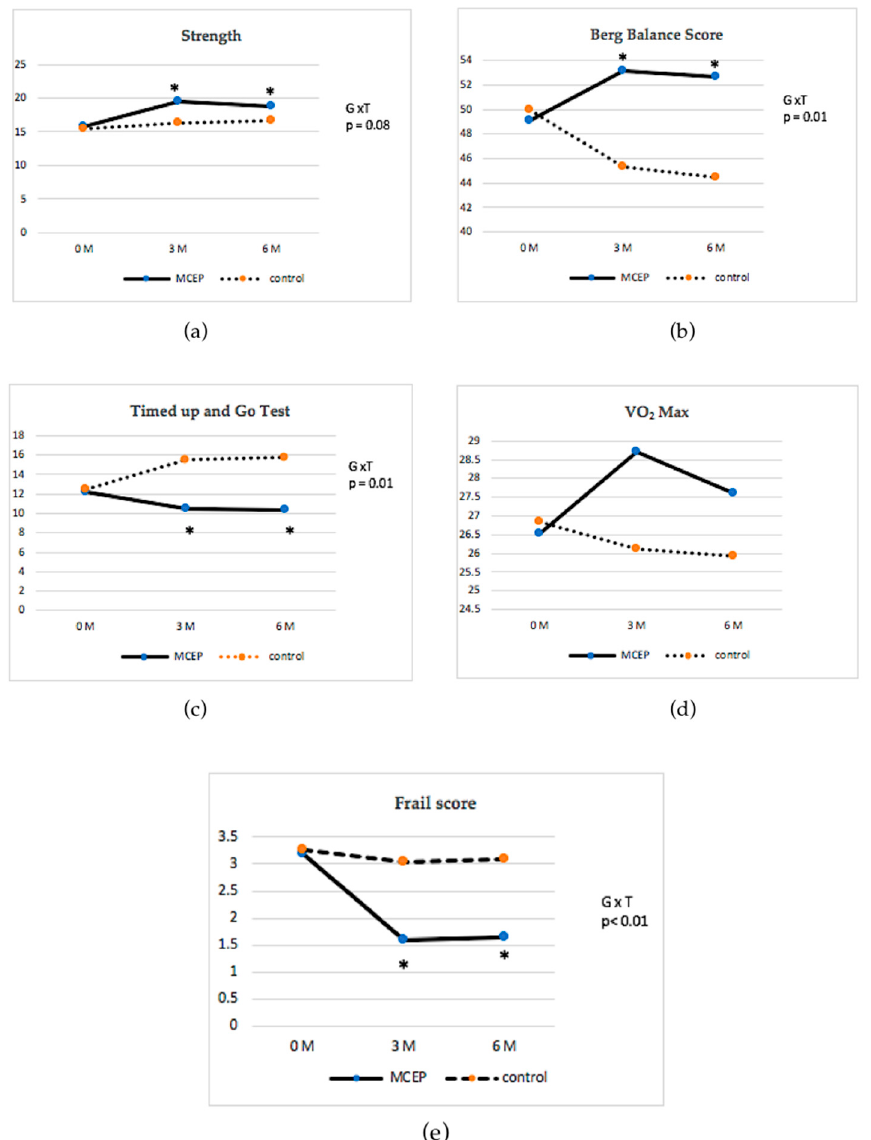
Figure 2. Change in physical performance from baseline to the end of the study between the intervention and control groups with interaction e ff ects of group x time as follows: ( a ) change in strength; ( b ) change in Borg Balance Score; ( c ) change in Timed Up and Go test; ( d ) change in Vo 2 Max; and ( e ) change in frailty score. Values are mean ± standard deviation. * = Significantly di ff erent at p < 0.05 .